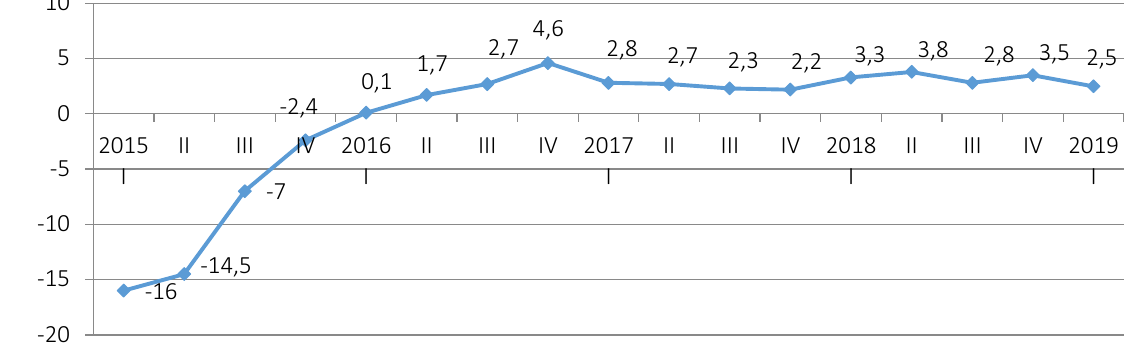
Figure 4. Changes in real GDP according to the State Statistics Service of Table 2. Acquisition of capital investments in%